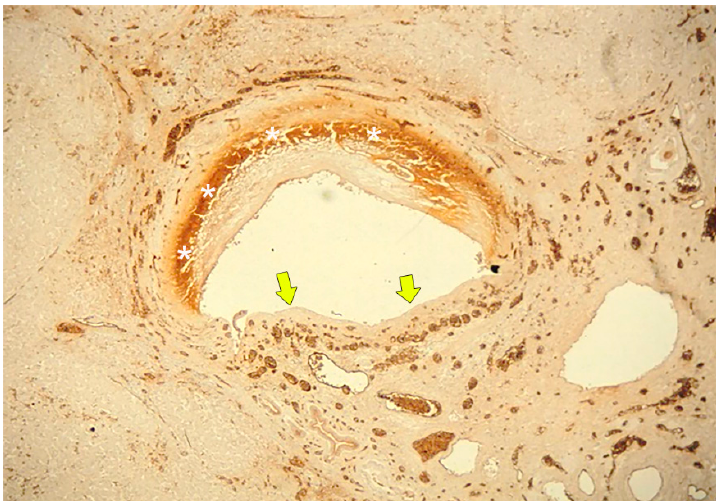
Figure 6. Photomicrograph of BDN. About the half of the bile duct wall shows necrotic change and shows a dark brown color (*). The inner layer of the PBP totally disappears beneath the basement membrane of the bile duct epithelium (arrows). In contrast, the outer layer of the PBP is dilated and increased in number (arrowheads). (Immunostaining of factor VIII; original magnification, ×40.).